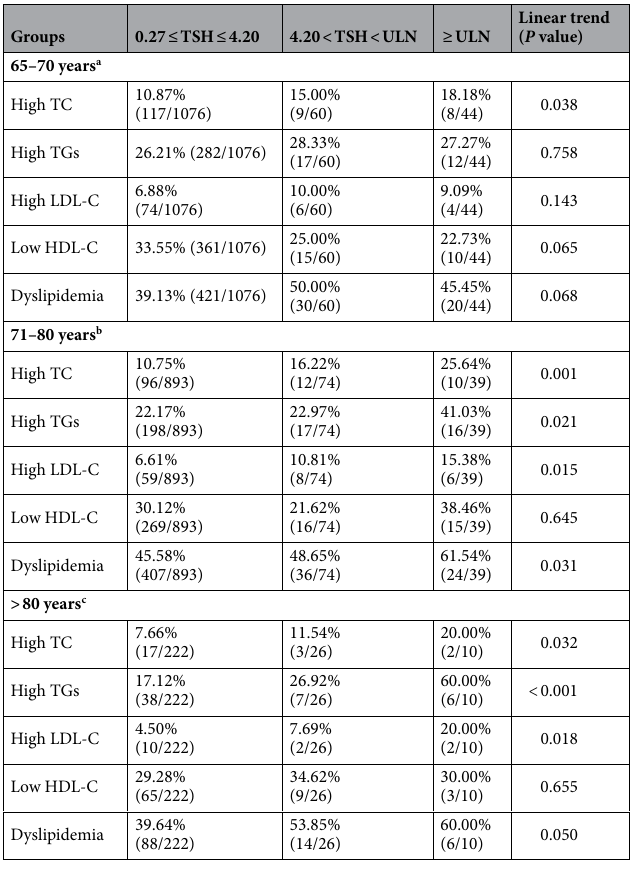
Table 4. Prevalence of dyslipidemia in elderly people stratified by age (n = 2460). ULN of TSH for each group was 5.51mIU/L a , 5.89 mIU/L b , 6.70 mIU/L c , respectively. ULN, upper limit of normal; TSH, thyroid stimulating hormone; TC, total cholesterol; TGs, triglycerides; LDL-C, low density lipoprotein cholesterol; HDL-C, high density lipoprotein cholesterol.